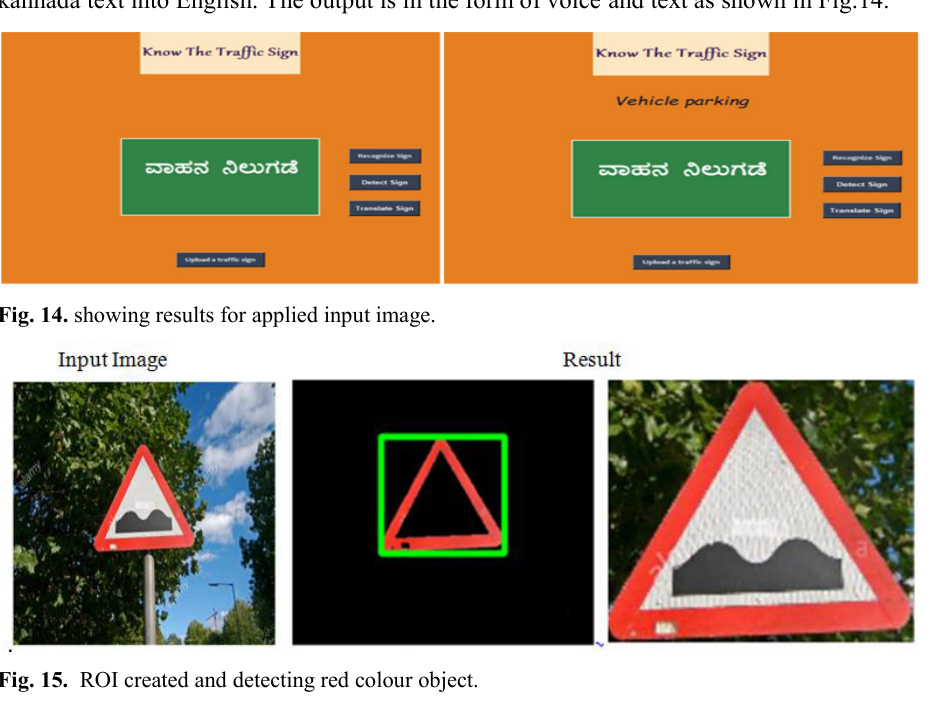
When a kannada text is uploaded, the function segments the characters from the word. At last, the segmented characters are passed into pre-trained model to get the translated kannada text into English. The output is in the form of voice and text as shown in Fig.14.